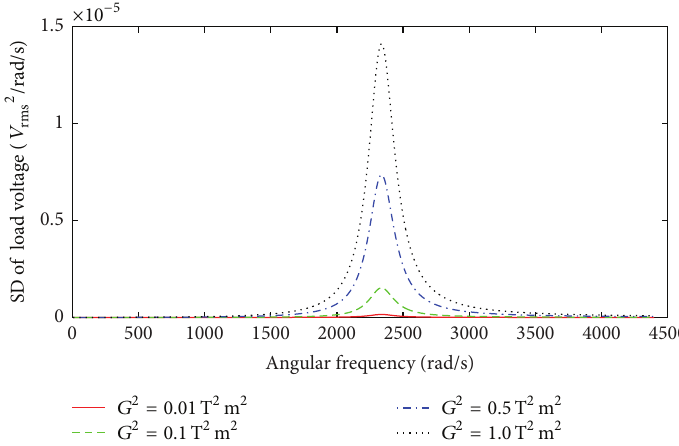
Figure 4: SD of the load voltage as a function of angular frequency for various values of 𝐺 2 , 𝑄 𝑚 = 5.7 .